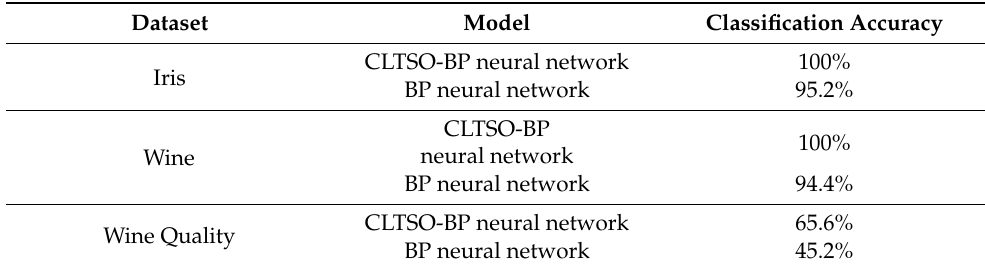
Table 14. The comparison results of the two models. Dataset